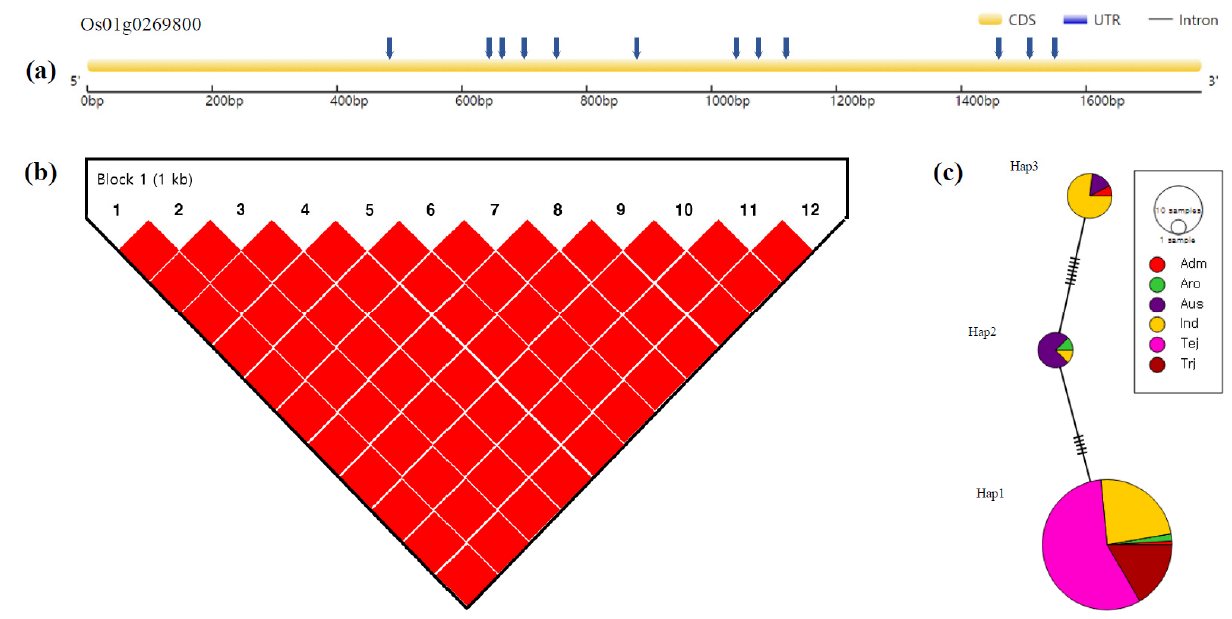
Figure 4. Haplotype analysis of Os01g0269800 . ( a ) Schematic representation of gene structure and SNPs positions in Os01g0269800 . Yellow block represents exon and blue vertical bars represent SNPs. ( b ) Linkage disequilibrium (LD) analysis of SNPs in Os01g0269800 . D’ was used to indicate LD level, with LD blocks defined using the Confidence Intervals function in the analysis software. Red blocks indicate complete LD between each SNP. ( c ) Haplotype variation analysis. Colors indicate rice subspecies as indicated in the legend. Circle size indicates the number of varieties in each Hap. Traverse lines represent the extent of variation between three haplotypes. Table 2. Results of haplotype analysis of Os01g0269800 .